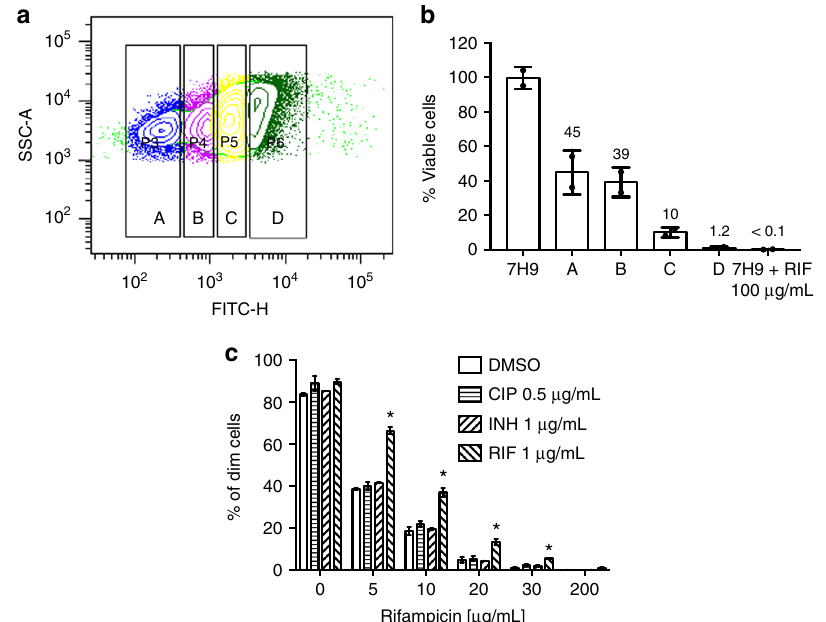
Fig. 2 Mycobacterium smegmatis exposed to rifampicin results in a distinct and speci fi c rifampicin tolerance. a Gating strategy for sorting of M. smegmatis by fl uorescence intensity following 18-h exposure to 10 µ g ml – 1 rifampicin in axenic culture. In all, 10 6 cells were sorted from each gate, and then 1000 bacteria from each sub-population plated onto drug-free agar medium. b Indicated sorted sub-populations from ( a ) and M. smegmatis exposed to 100 µ g ml − 1 rifampicin and drug-free medium were then plated on non-selective medium to calculate survival. Error bars represent standard deviation of two technical replicates. c M. smegmatis was exposed to sub-MIC concentrations of the indicated antibiotics or vehicle for 3 h, then washed, stained with AF488 and then inoculated into 7H9-rifampicin at the indicated concentrations. After 16-h incubation, fl uorescence dilution was determined by fl ow cytometry as before. Error bars represent biological duplicates. * p < 0.05 by Student ’ s t